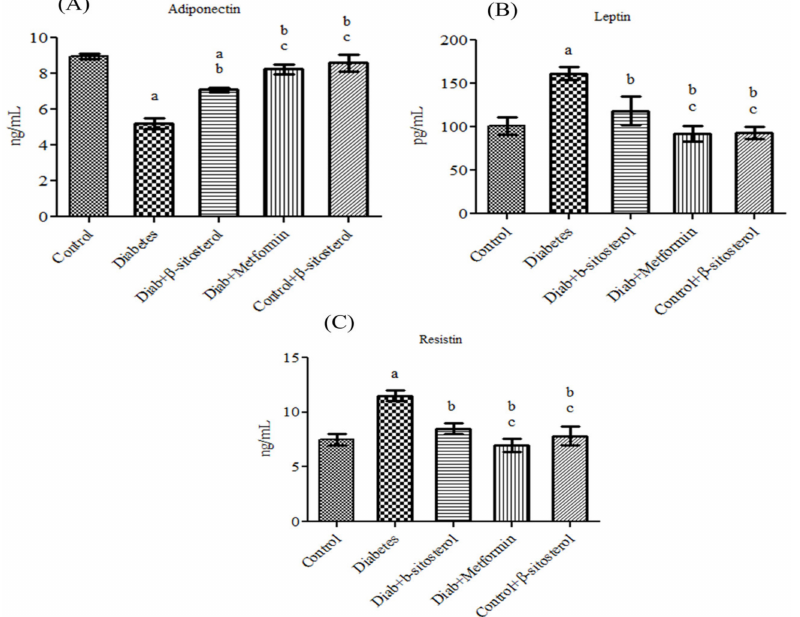
Figure 1. Effect of β -sitosterol (SIT) on serum adiponectin, leptin and resistin levels in type-2 diabetic rats. Each bar represents mean ± SEM ( n = 6). Significance at p < 0.05, a significantly different from the control group, b significantly different from the diabetic control and c significantly different from the β -sitosterol treated diabetic